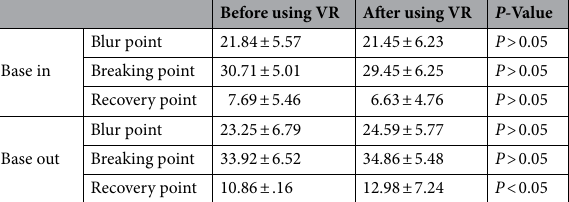
Before using VR After using VR P -Value